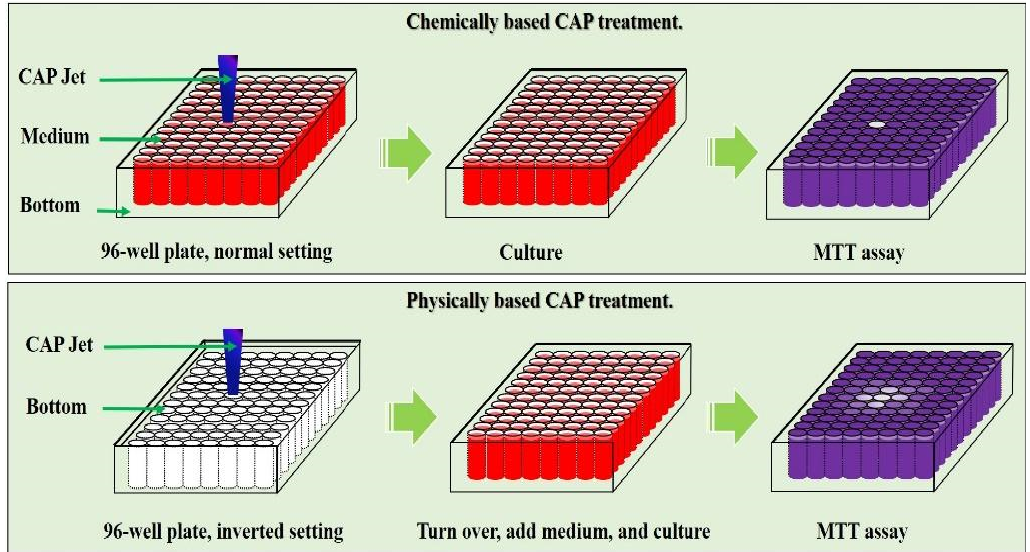
Figure 5. Physical factors in CAP can affect a much bigger area than the plasma contacting area on samples. A representative illustration of chemical factors and physical factors in CAP and their kill- ing effect on cancer cells in vitro